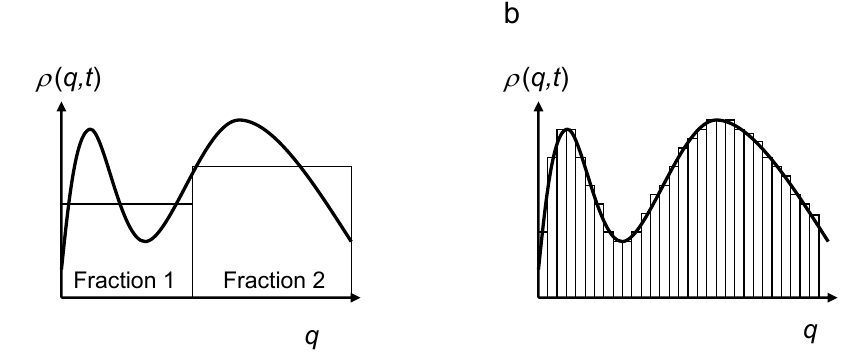
Fig. 3. Illustration of the way in which an underlying continuous distribution is approximated by concatenating a large number of measure- ments along the axis of measurement. In (a) the underlying distribution is fractionated into two arbitrary fractions that are difficult to relate to the underlying distribution, whereas in (b) the number of fractions has been increased so that the distribution approaches the underlying continuous